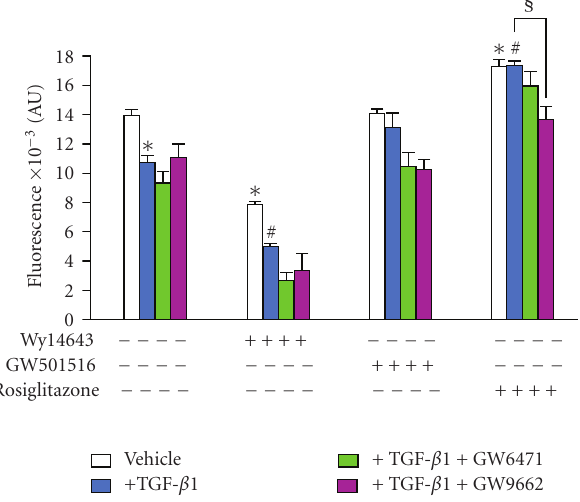
Figure 7: Selective reversion of anti-TGF- β 1 potency of PPAR agonists on global MMP (-1, -2, -3, -7, and -9) activity in rat chondrocytes . Chondrocytes, embedded in alginate beads (5.10 4 cells per bead), were pretreated for 2h with Wy14643 (100 μ M), GW501516 (100 nM), or rosiglitazone (10 μ M), in the presence or absence of synthetic PPAR α (GW6471, 10 μ M) or synthetic PPAR γ (GW9662, 10 μ M) antagonists, before stimulation with 10ng/mL TGF- β 1 for 72h. Global MMP (-1, -2, -3, -7, and -9) activities was evaluated by fluorigenic assays in culture supernatants ( n = 4). Data were expressed as mean ± SEM and statistically significant di ff erences from the control were indicated as ∗ P < . 05, from TGF- β 1-treated cells as # P < . 05, and from “TGF- β 1+agonists”-treated cells as § P < .